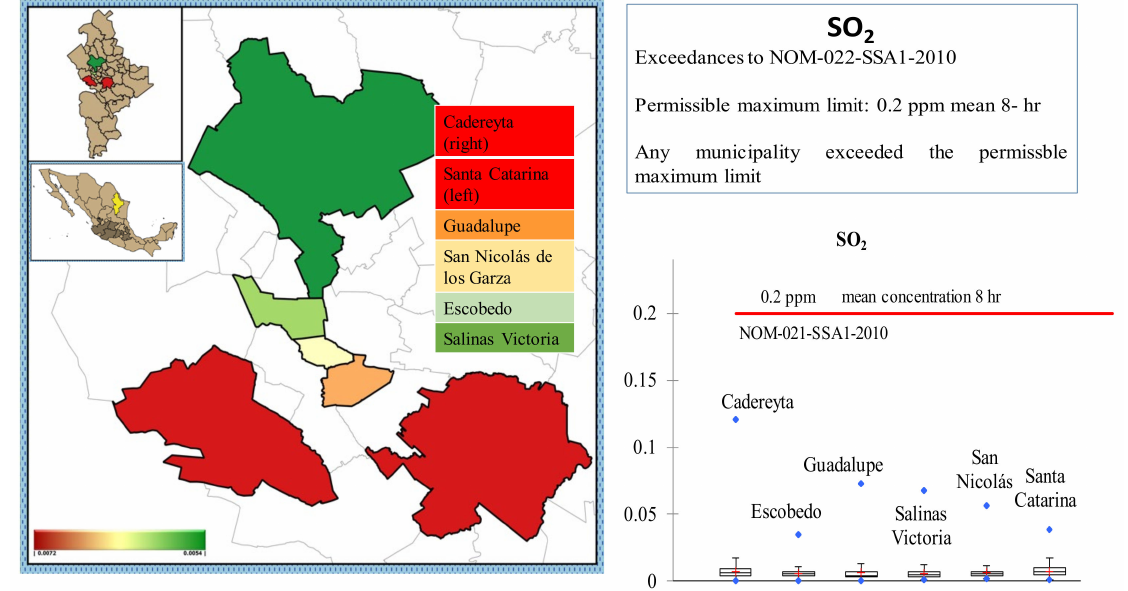
Figure 5. Mean concentrations of SO 2 in MAM during